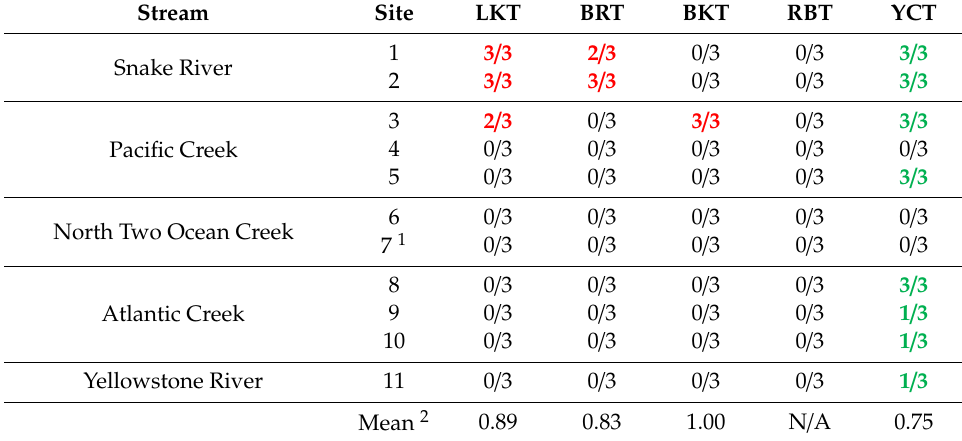
Table 1. Presence of environmental DNA (eDNA) for nonnative fish, including lake trout (LKT), brown trout (BRN), brook trout (BKT), rainbow trout (RBT), and native Yellowstone cutthroat trout (YCT) in streams near Two Ocean Pass. The site numbers refer to locations on Figure 3. The number in each species column represents the number of PCR wells out of 3 that tested positive for each sample. The numbers in red and green indicate sites where nonnatives and native cutthroat trout were detected, respectively. Lake trout samples were run with a standard curve, generating a concentration in DNA copies per liter for Site 1 (67.92 copies / L), Site 2 (209.83 copies / L) and Site 3 (2.05 copies /